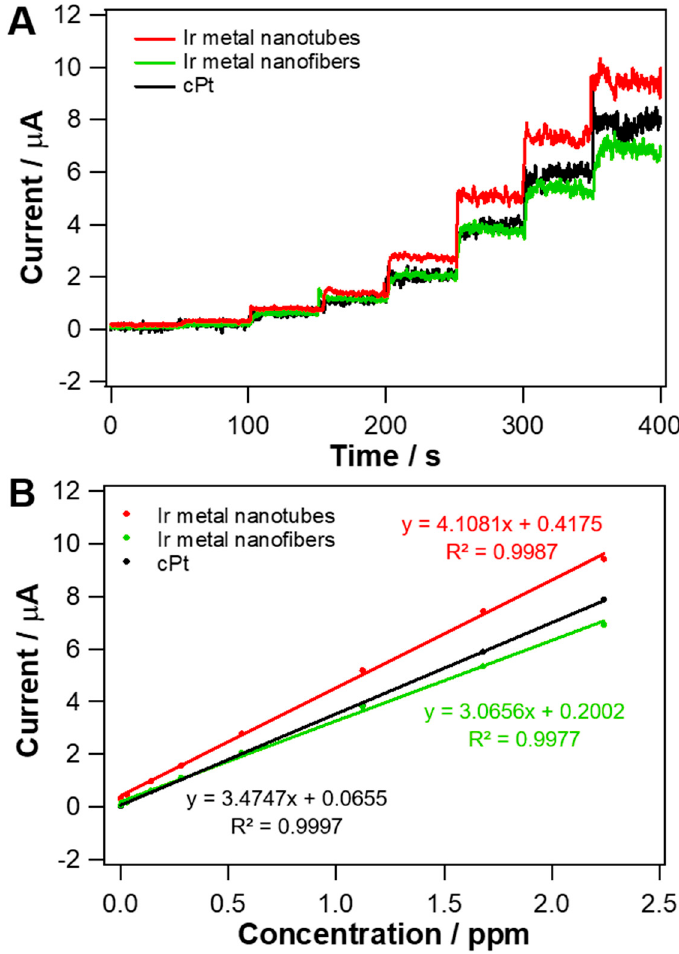
Figure 7. ( A ) Dynamic current responses of cPt, Ir metal nanofibers and Ir metal nanotubes-loaded GC electrode to the successive increase of CO concentration (0, 0.028, 0.14, 0.28, 0.56, 1.12, 1.68 and 2.24 ppm), in 0.5 M H 2 SO 4 aqueous solution containing 0.03 M NaCl. Electrode potential: 0.7 V vs. SCE. ( B ) Corresponding calibration curves to (A).